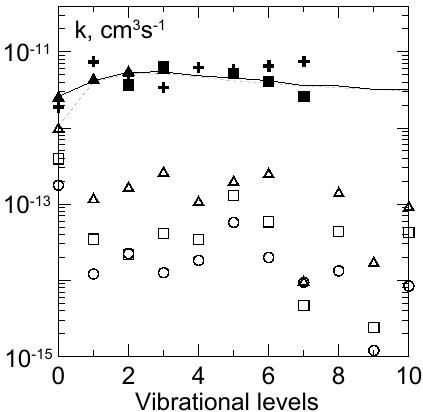
Fig. 7. The calculated total quenching rate coefficients of N 2 (A 3 6 + u ,v)+O 2 (X 3 6 − g , v =0) (solid line) are compared with ex- Figure 7. The calculated total quenching rate coefficients of N 2 (A 3 Σ u+ ,v) + O 2 (X 3 Σ g– ,v=0) (solid perimental data by Dreyer et al. (1974) (crosses), Thomas and Kauf- line) are compared with experimental data by Dreyer et al. (1974) (crosses), Thomas and man (1985) (solid triangles), De Benedictis and Dilecce (1997) Kaufman (1985) (solid triangles), De Benedictis and Dilecce (1997) (solid squares). The (solid squares). The calculated contributions of Eqs. (5a), (5b), (5c) calculated contributions of (5a), (5b), (5c) processes, molecular oxygen dissociation – open processes, molecular oxygen dissociation – open triangles, open triangles, open squares, circles and dotted line, respectively. squares, circles and dotted line, respectively.